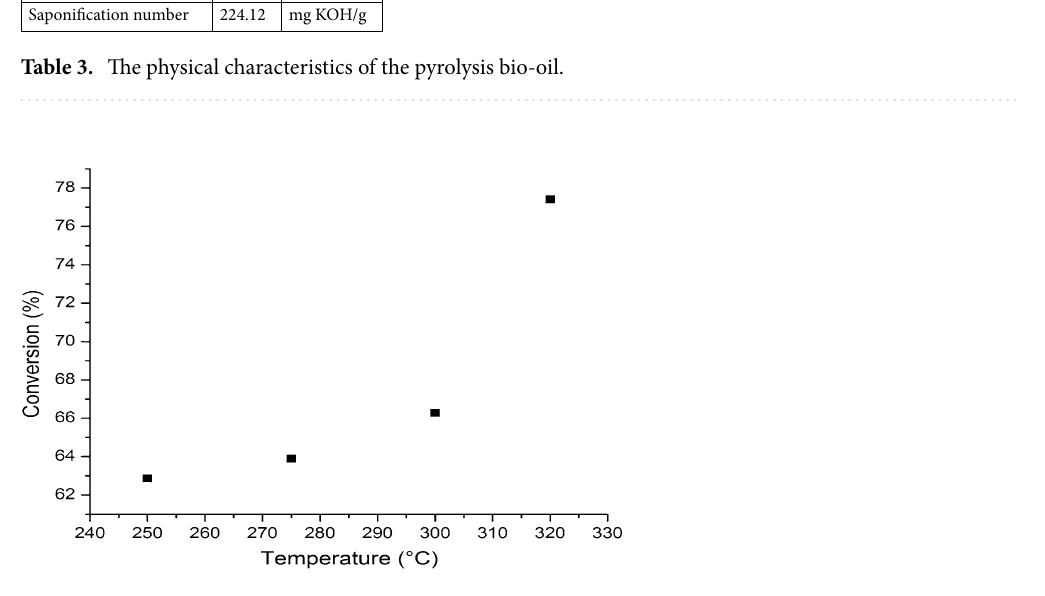
Figure 7. The influence of temperature over bio-oil